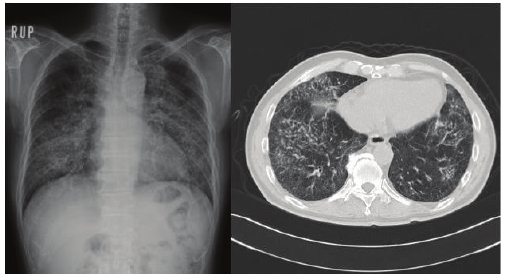
Figure 2: Chest radiography and CT findings at the first visit. Diffuse fine nodular or reticular shadow in both lung fields (pre- dominant in lower lungs) was seen.